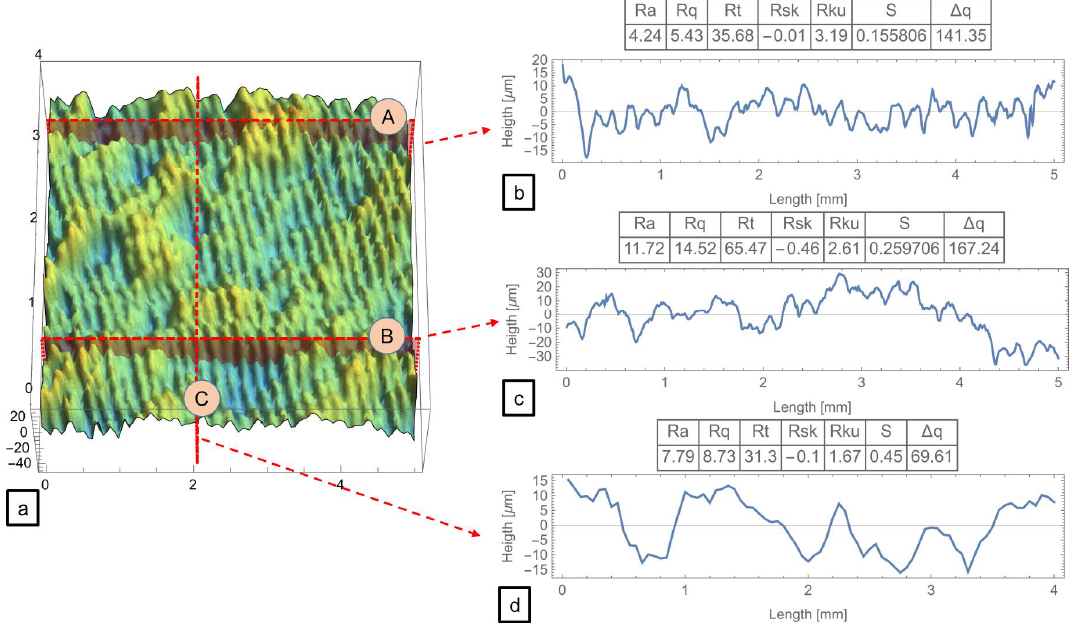
Figure 4. 3D surface map at 0° slope ( a ): profiles A ( b ) and B ( c ) extracted horizontally and profile C extracted vertically ( d ).